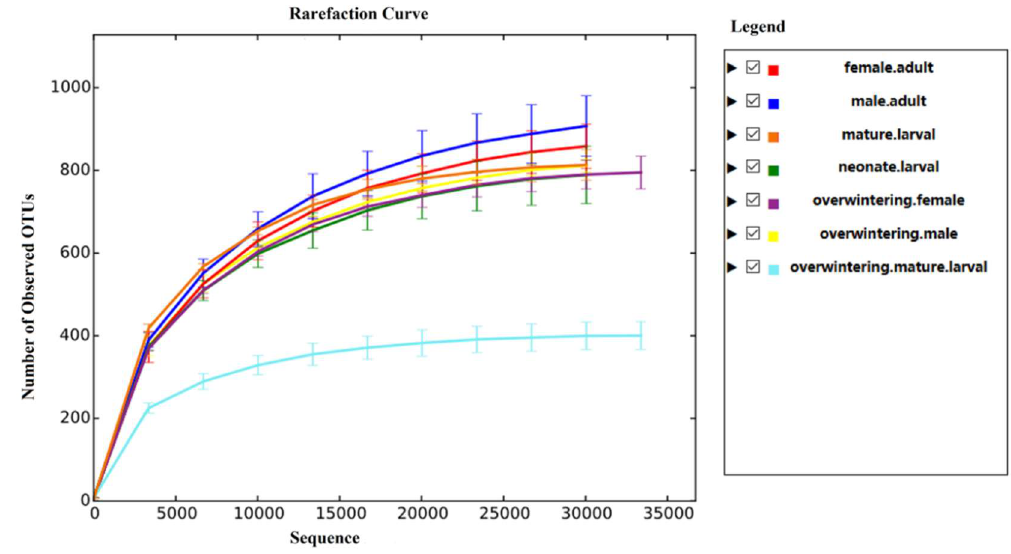
Figure 1. The rarefaction curve in each sample (Note: OTU: Operational Taxonomic Unit).